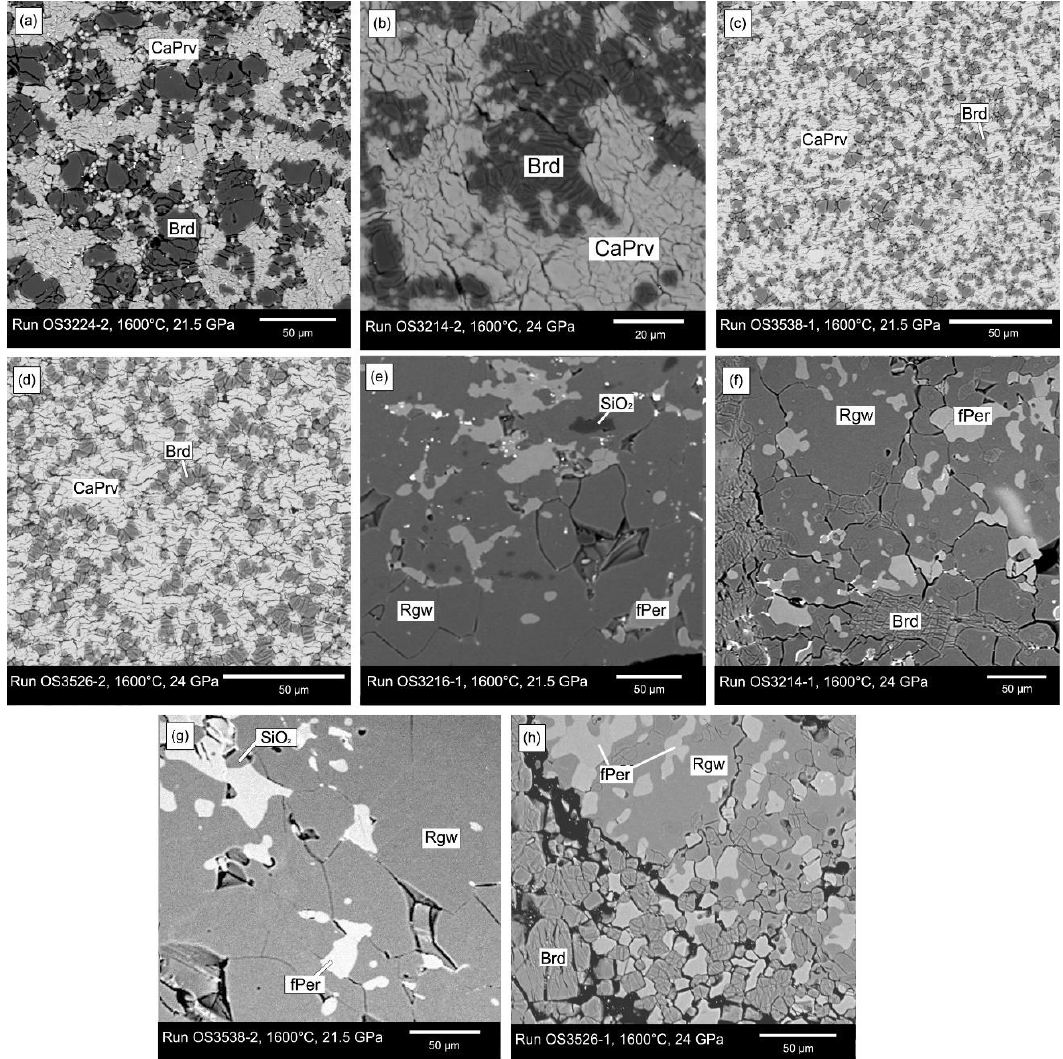
Figure 1. Back-scattered electron (BSE) images illustrating the phase assemblages and textural relationships in the samples obtained at 21.5 and 24 GPa from different starting compositions: ( a , b ): CaMgSi 2 O 6 (98 wt %) + TiO 2 (0.5 wt %) + Cr 2 O 3 (0.5 wt %) + (La 2 O 3 + Sm 2 O 3 + Lu 2 O 3 ) (1 wt %); ( c , d ): CaMgSi 2 O 6 (98 wt %) + TiO 2 (0.5 wt %) + Cr 2 O 3 (0.5 wt %) + (REE (Rare Earth Elements) oxides) (1 wt